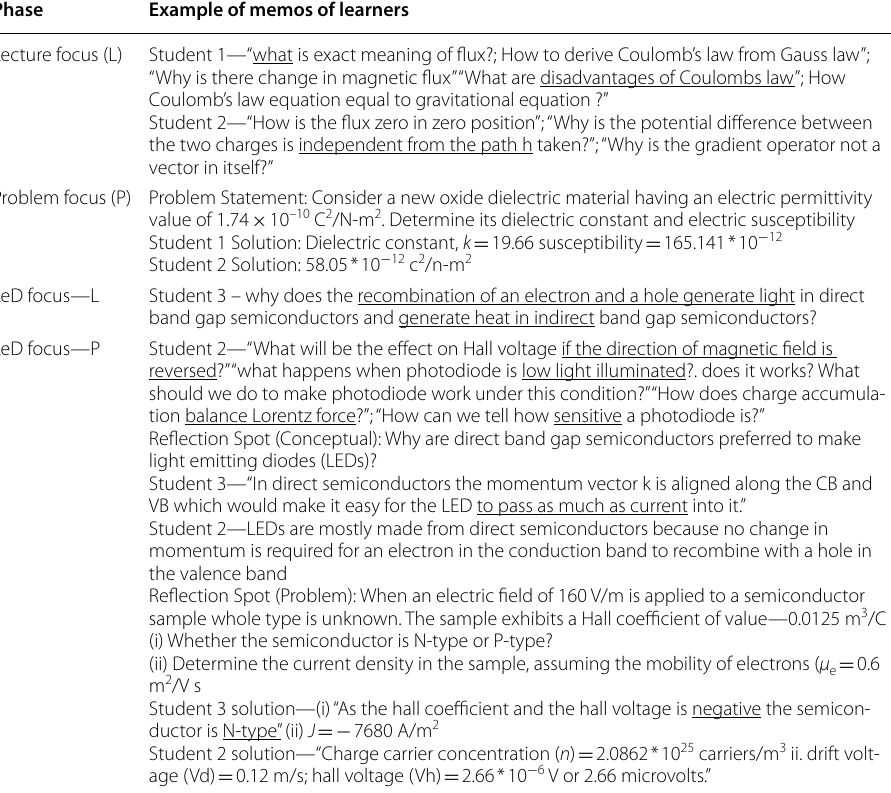
Table 5 Qualitative analysis of memos posted by students Phase Example of memos of learners Lecture focus